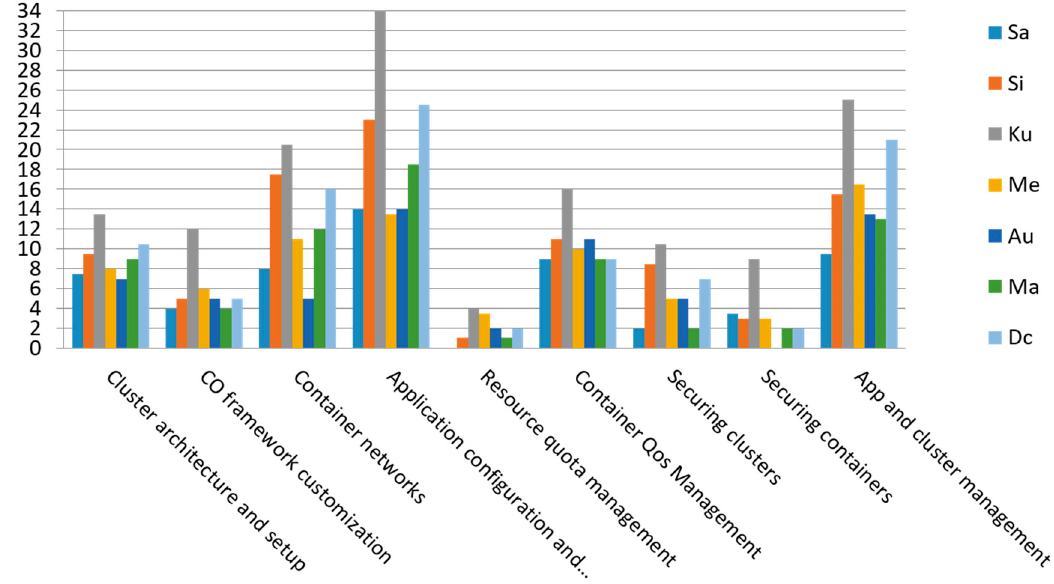
Figure 9. The total number of features supported by each of the CO frameworks is shown for the 9 aspects.